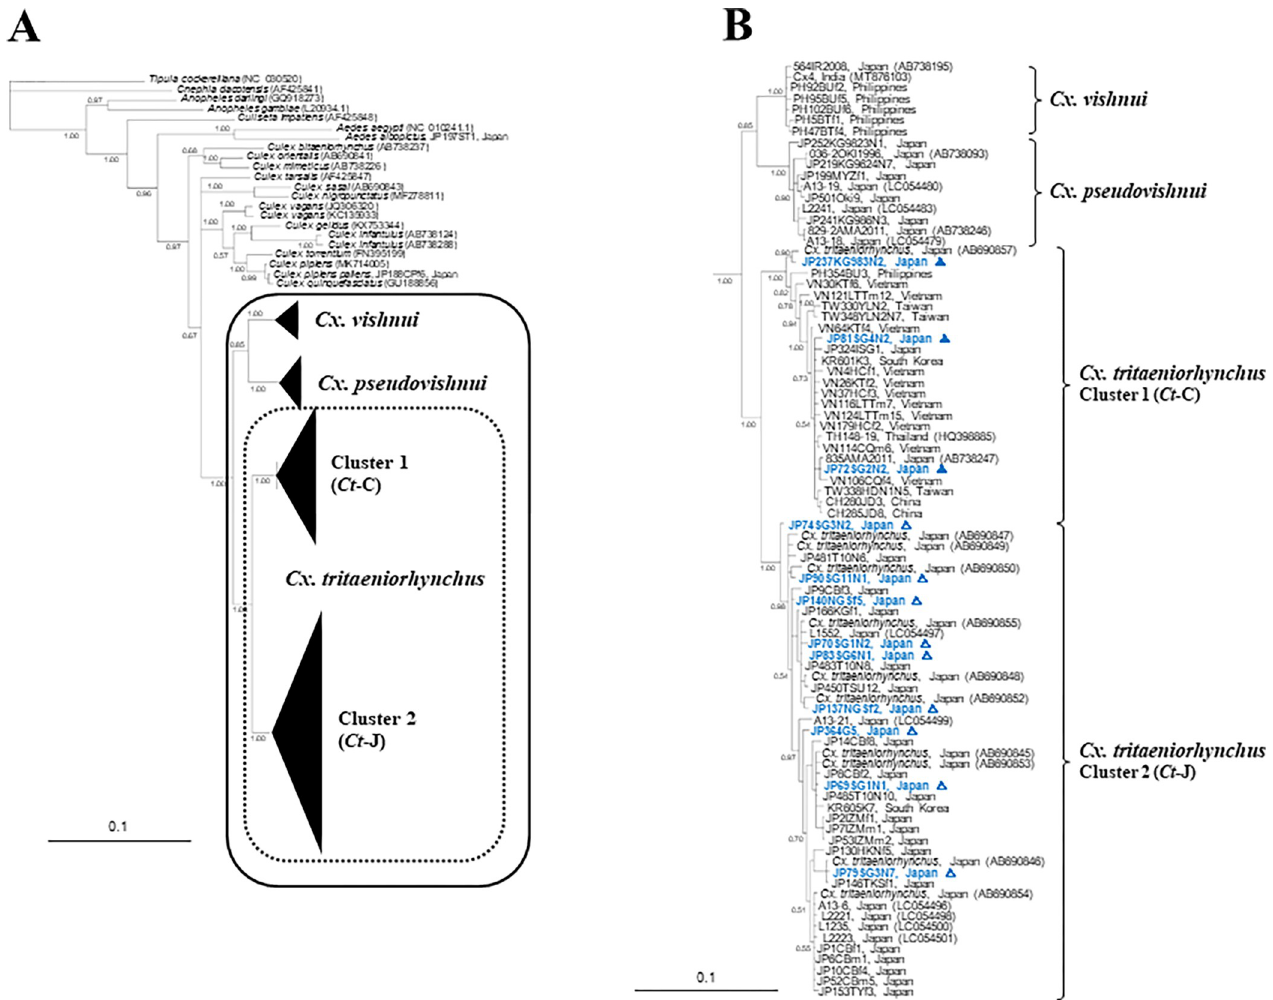
Fig 2. Bayesian inference of a phylogenetic tree based on the partial nucleotide sequences of the mitochondrial COI region (658 bp) of 69 Cx . tritaeniorhynchus specimens. A: Summarized Bayesian phylogenetic tree with 86 COI sequences of Cx . vishnui subgroup and 23 sequences as an outgroup. The black frame indicates Cx . vishnui subgroup, and the dotted frame indicates Cx . tritaeniorhynchus . B: Expanded subtree of 86 COI sequences of Cx . vishnui subgroup. Numbers at nodes indicate posterior probability values ( > 0.7) based on 150,000 trees: two replicate Markov chain Monte Carlo runs, consisting of six chains of 10 million generations each sampled every 100 generations with a burn-in of 25,000 (25%). Bar denotes the nucleotide similarity distance. GenBank accession numbers for sequences used in the phylogenetic analysis are in S1 Table. Open and closed triangles with blue indicate Ct -J and Ct -C of the Cx . tritaeniorhynchus , respectively, captured in net-traps (NTs) and a Johnson-Taylor suction trap (JT-ST).